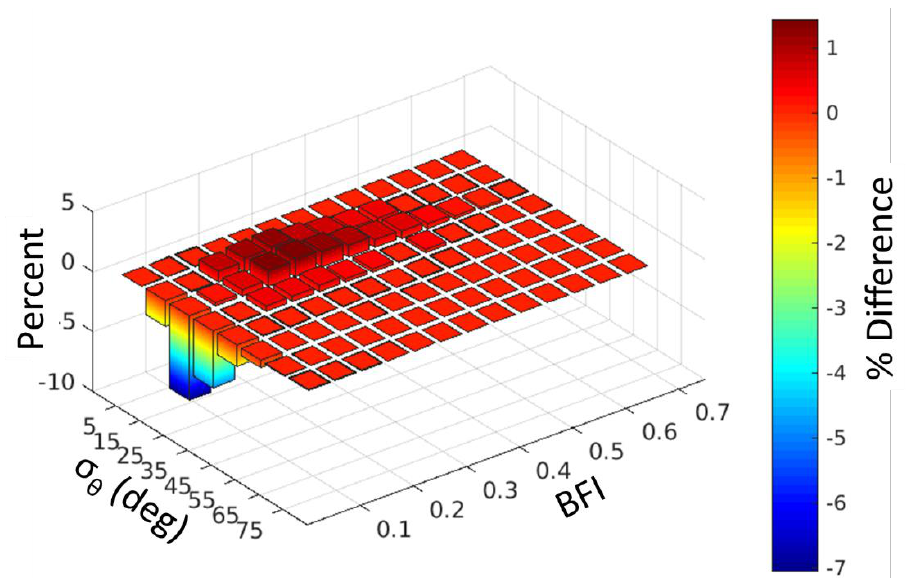
Figure 9. Combined di ff erence histogram showing percentage di ff erence (rogue minus non-rogue) as a